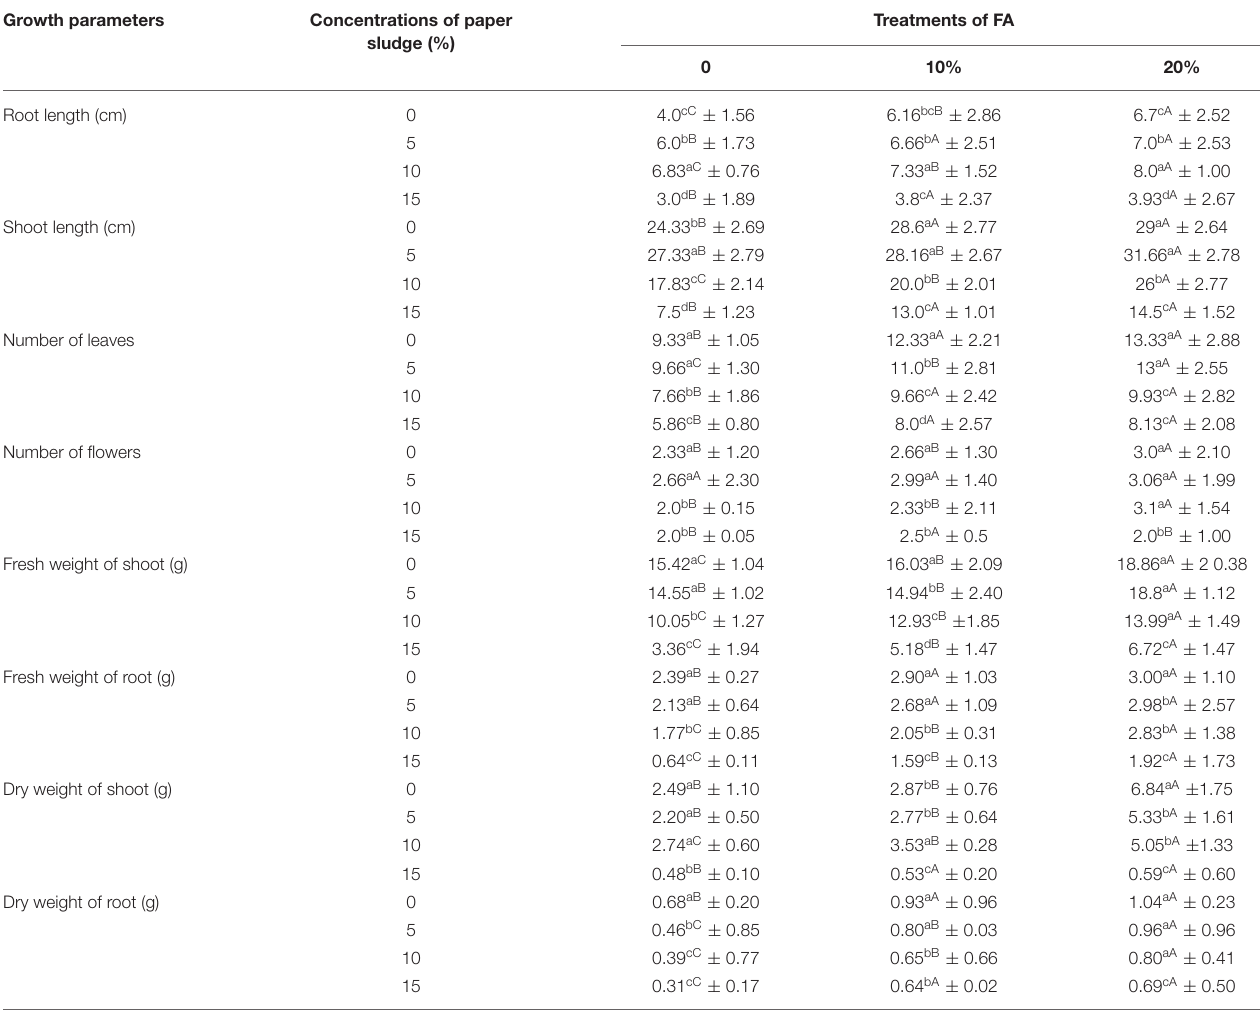
TABLE 2 | Comparison of morphological parameters of Brassica napus L. irrigated with fulvic acid grown at different concentrations of paper sludge. Growth